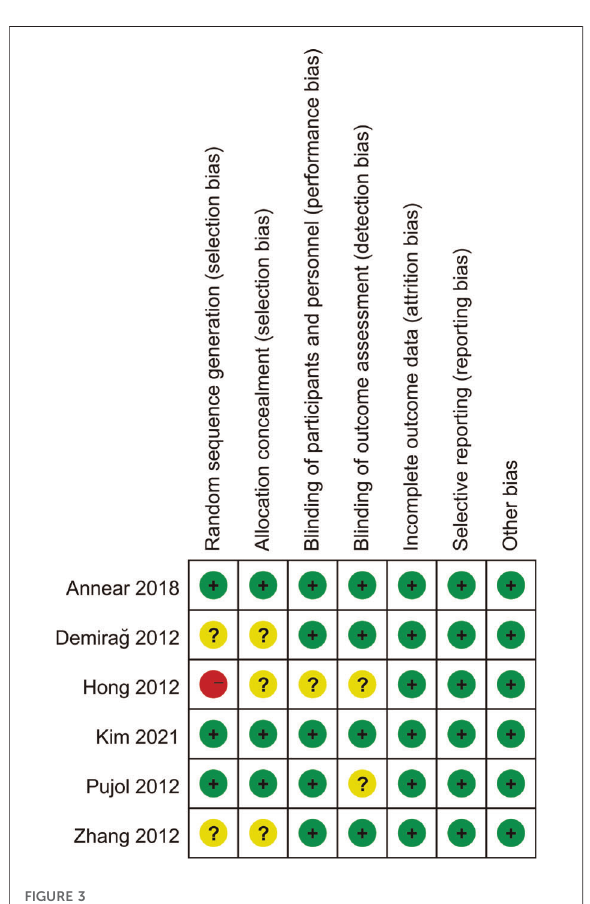
FIGURE 3 Summary of literature quality assessment results of included